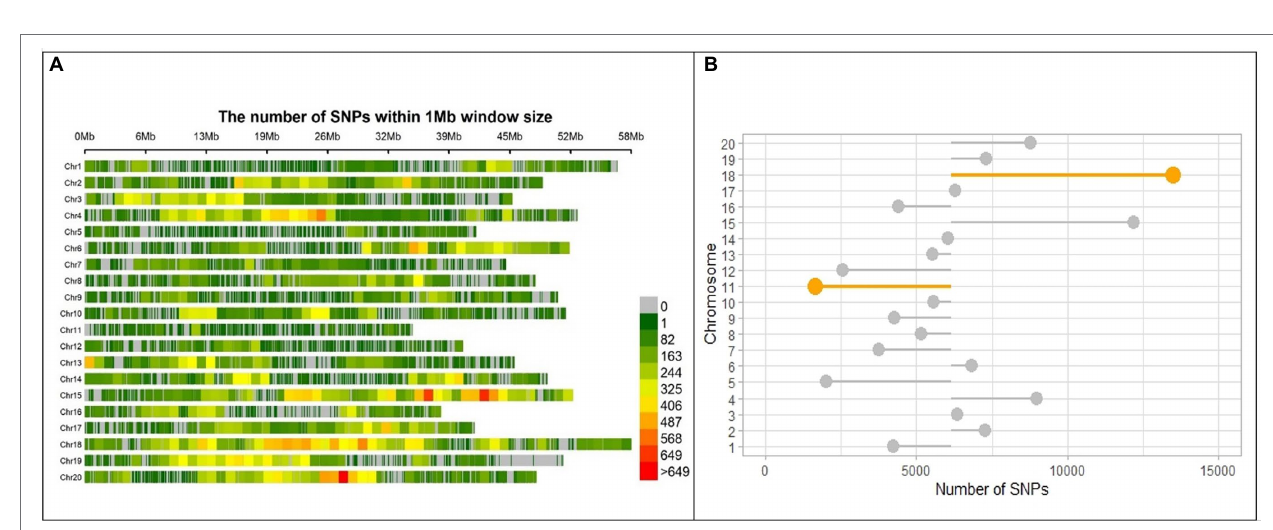
FIGURE 3 | SNP marker distribution on the genome of SoyMAGIC RILs. (A) Genome-wide distribution of SNP markers in the RILs of soybean MAGIC population. The number of SNPs is calculated and visualized in 1 Mb window size for each of the chromosomes (Chr). The number of markers per Mb is color-coded. (B) Number of SNP markers for each chromosome. The mean number of SNPs, 6317, across the whole genome was used as a baseline for intra-chromosome comparisons. Chromosomes 18 and 11 with highest and lowest number of SNPs are highlighted,